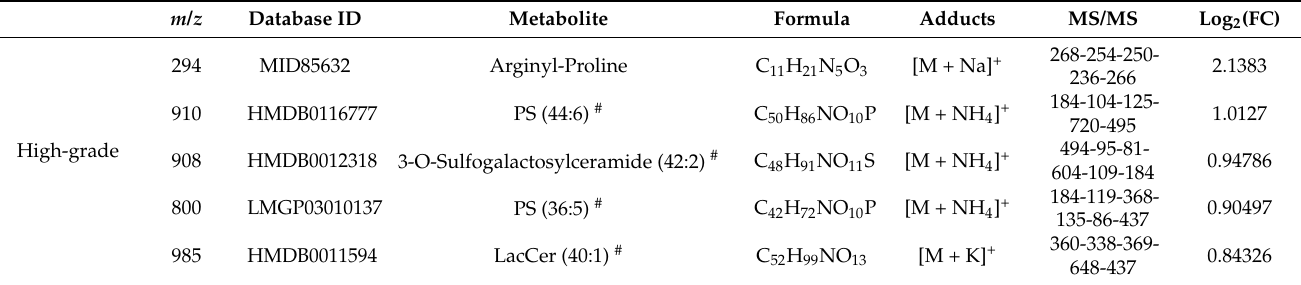
Figure 4. Receiving operating characteristic (ROC) curve analysis to determine the accuracy of the method to designate metabolites that can indicate high-grade meningioma and cancer progression.